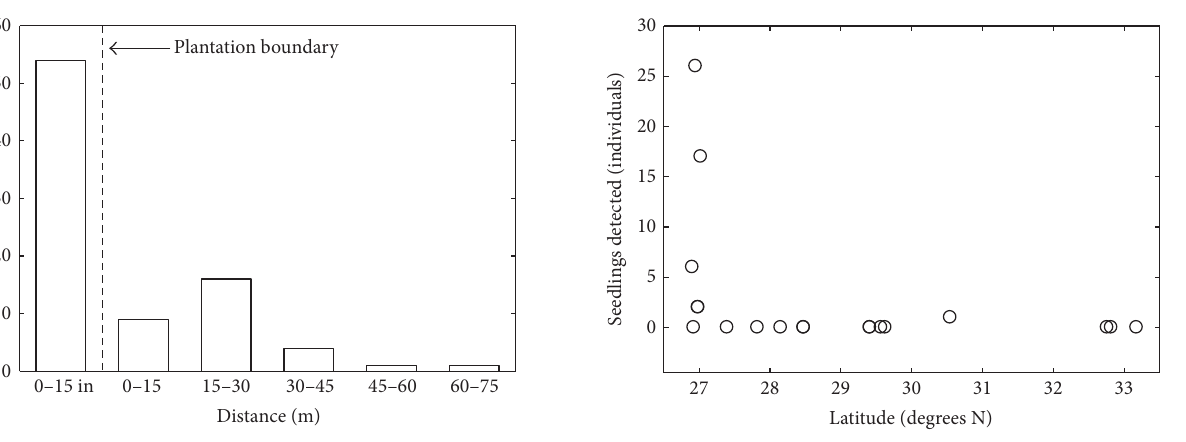
with some being